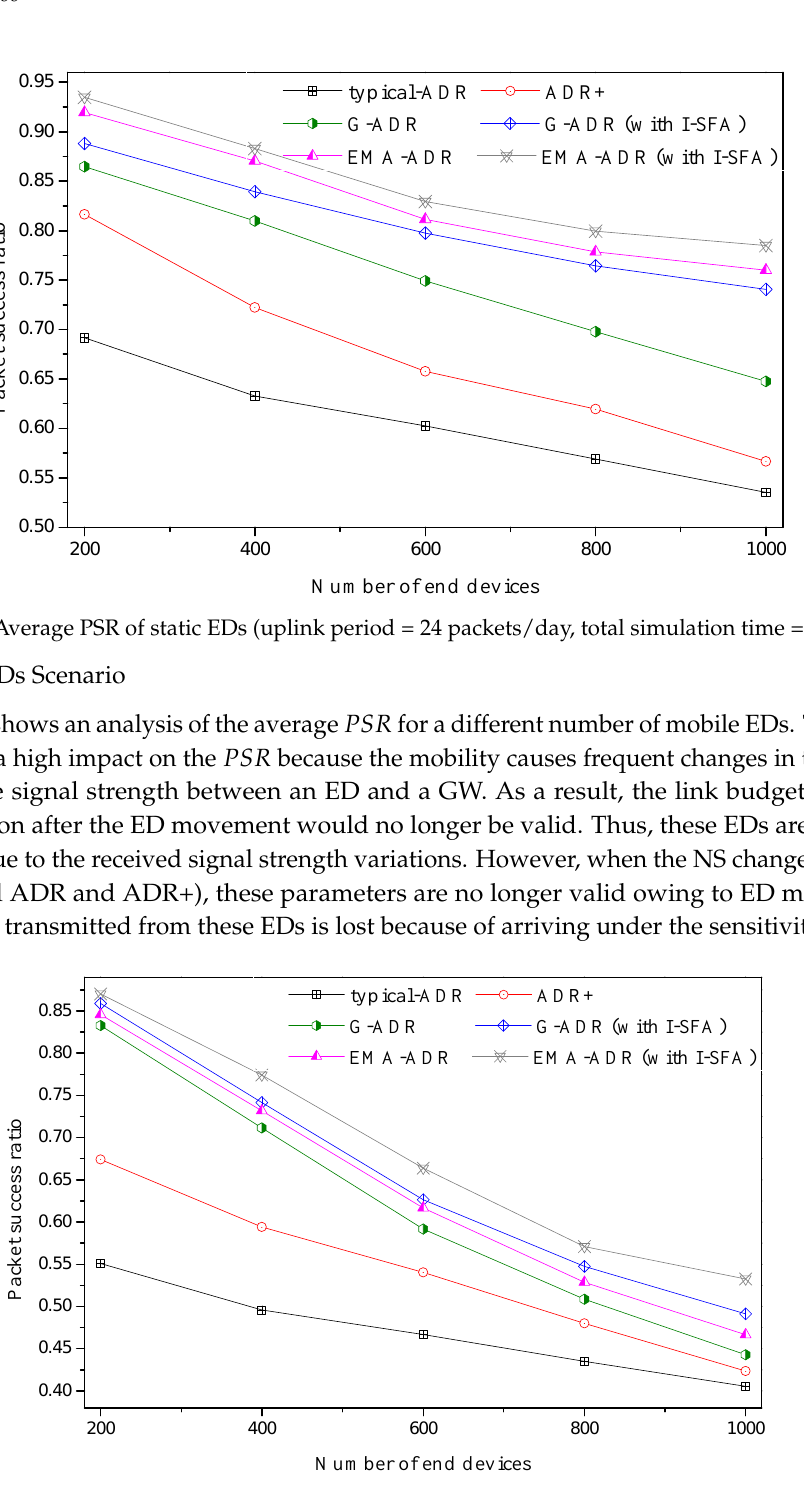
Figure 11. Average PSR of mobile EDs (uplink period = 24 packets/day, total simulation time = 4